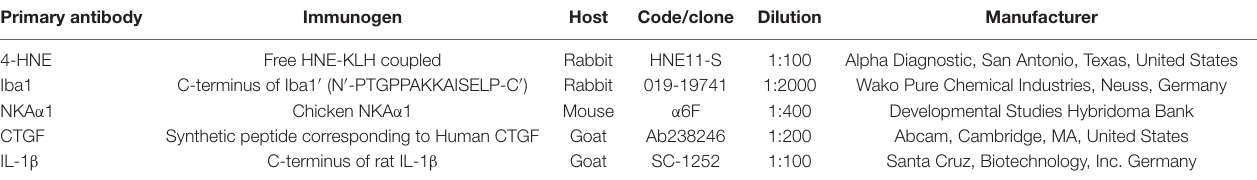
TABLE 1 | Antibodies used for